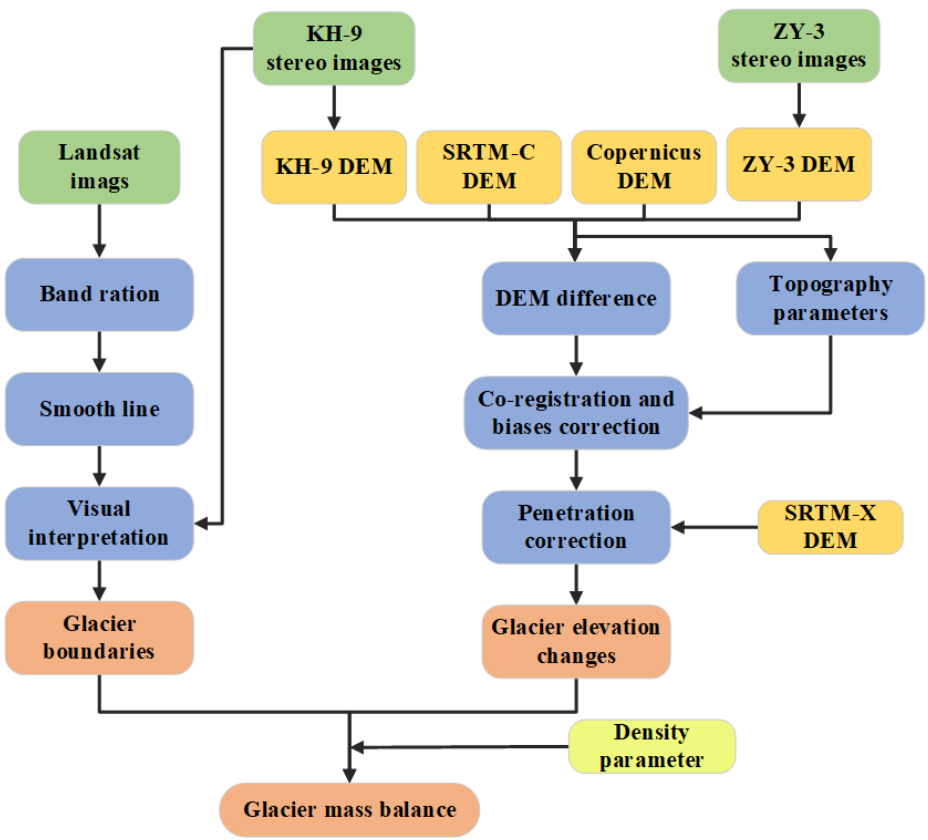
Figure 2. The workflow of our glacier area and mass balance measurements.